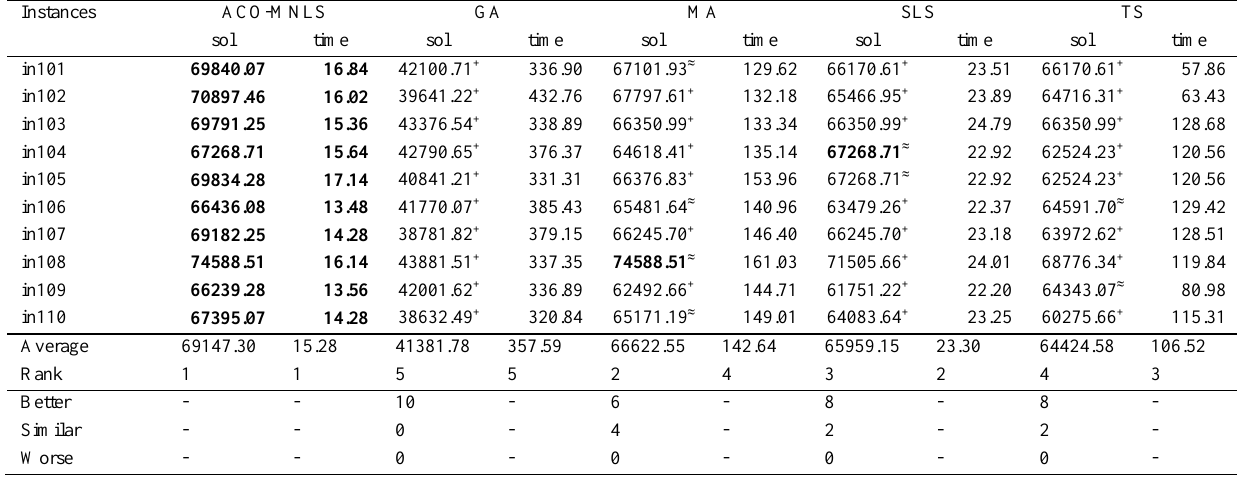
Table 2. Experimental results of proposed ACO-MNLS, GA, MA, SLS, and TS on some instances of REL-1000-500.